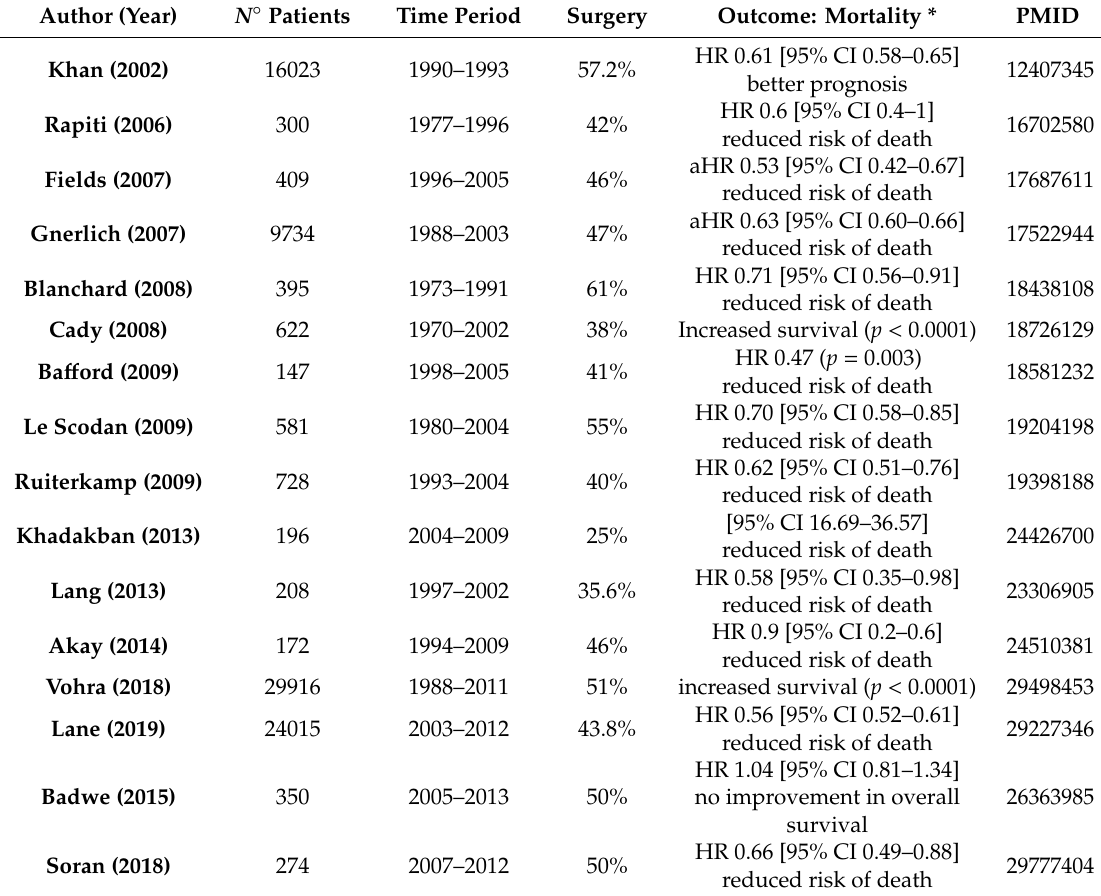
Table 1. Studies considered in the present article that were conducted to investigate the impact of locoregional treatment compared to systemic therapy in MBC on